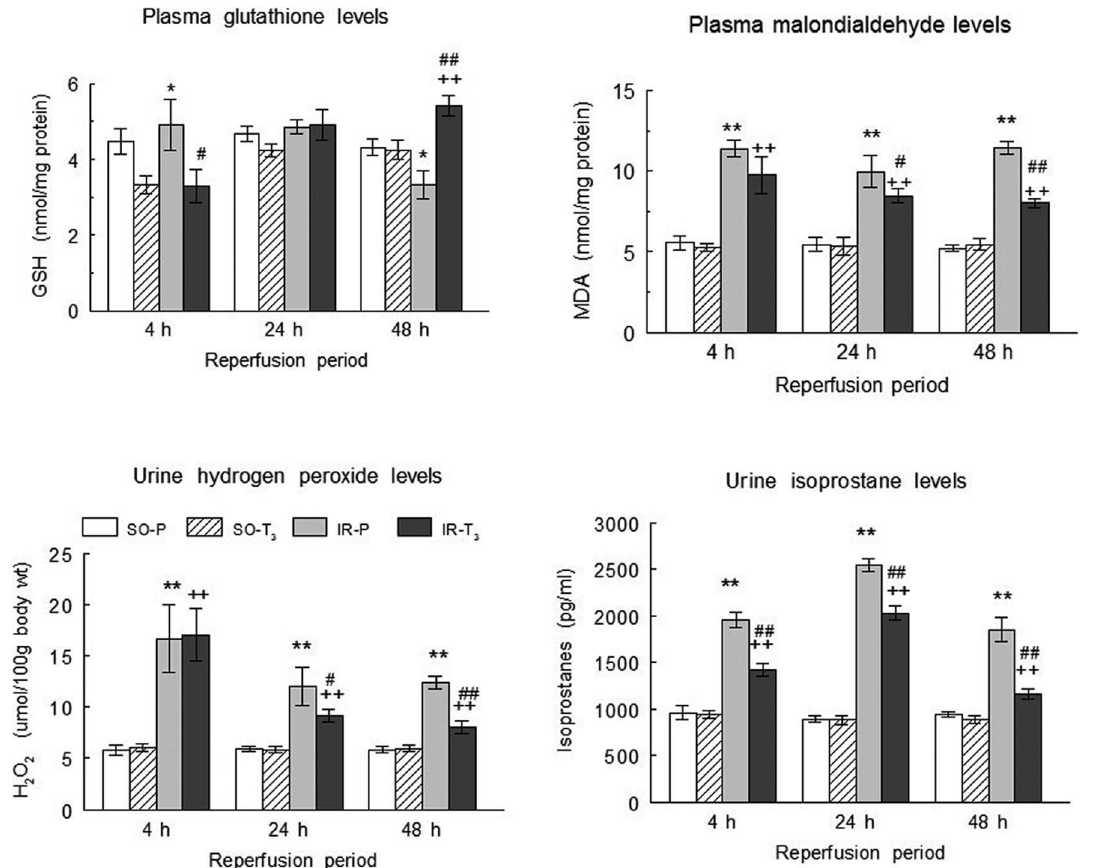
Figure 1. Plasma glutathione and MDA levels, and total urinary excretion of hydrogen peroxide and of isoprostanes. (Upper panels) Plasma glutathione and MDA levels, and (lower panels) total urinary excretion of hydrogen peroxide and of isoprostanes in the experimental groups (n=10 each group),: SO-P = sham-operated-placebo; SO-T 3 = sham-operated, T 3 -treated (100 m g/kg); IR-P= ischemia-reperfusion, placebo-treated; IR-T 3 = ischemia-reperfusion, T 3 -treated. Data are means 6 SEM. * p , 0.05, ** p , 0.001 versus SO-P group. + p , 0.01, ++ p , 0.001 versus SO-T 3 group. # p , 0.05, ## p , 0.001 versus IR-P